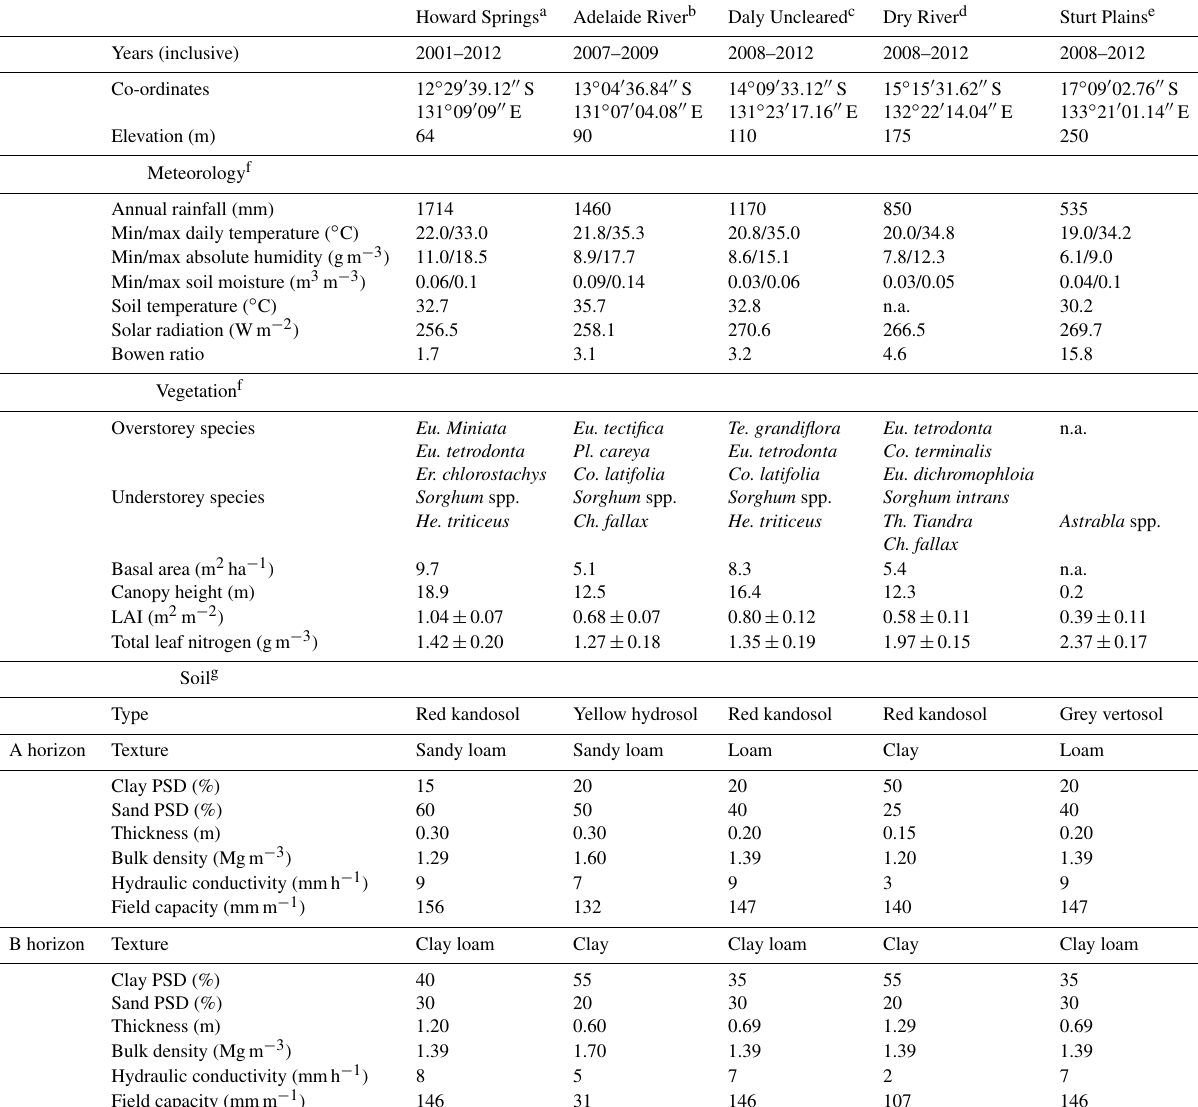
Table 1. Summarised data set information for each of the five savanna sites used in this study. This includes site descriptions pertaining to local meteorology, vegetation, and belowground soil characteristics. Where data were not available, the abbreviation n.a. is used. Definitions for the species genus mentioned in the table are as follows: Eucalyptus ( Eu. ), Erythrophleum ( Er. ), Terminalia ( Te. ), Corymbia ( Co. ), Planchonia ( Pl .), Buchanania ( Bu. ), Themda ( Th. ), Hetropogan ( He. ), and Chrysopogon ( Ch. ). Eddy covariance data sets relating to each of the five sites here can be download from